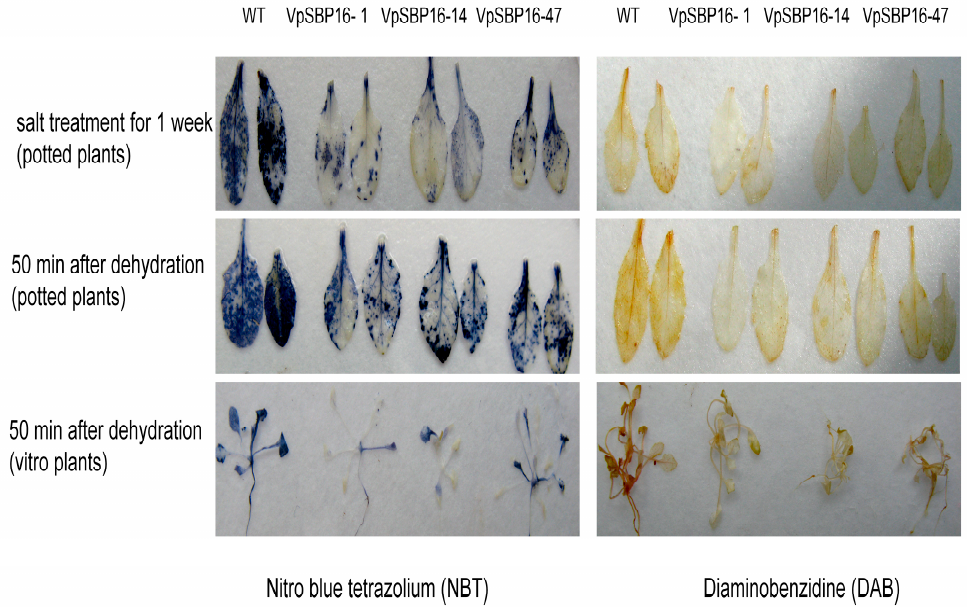
Figure 7. Histochemical staining assay of ROS accumulation with nitro blue tetrazolium (NBT) and diaminobenzidine (DAB) in 2-week-old wild type (WT), or VpSBP16-1, VpSBP16-14 and VpSBP16-47 transgenic lines after salt treatment for 1 week or after the transpirational water loss from 50 min. The experiment was repeated three times with 5–10 leaves or plants.